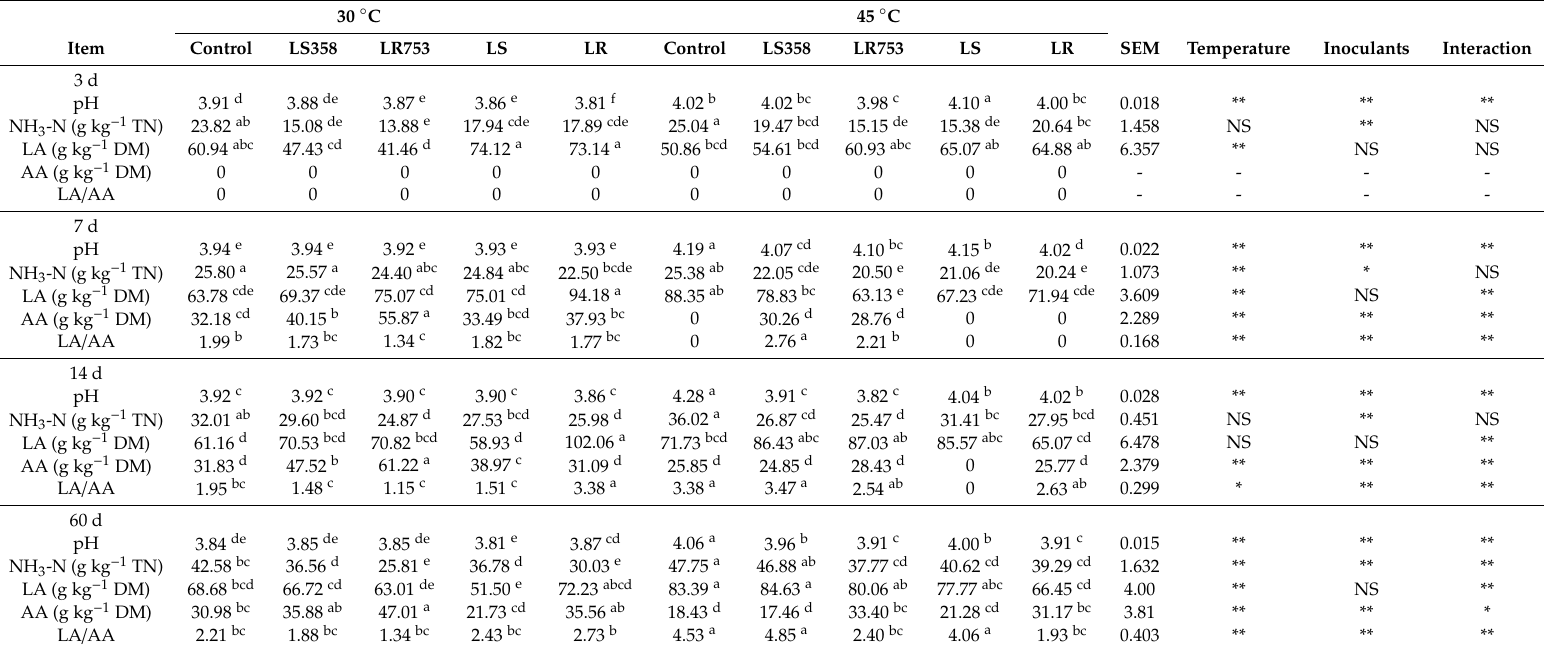
Table 1. Fermentation characteristics of corn silage prepared with two temperatures at di ff erent ensiling